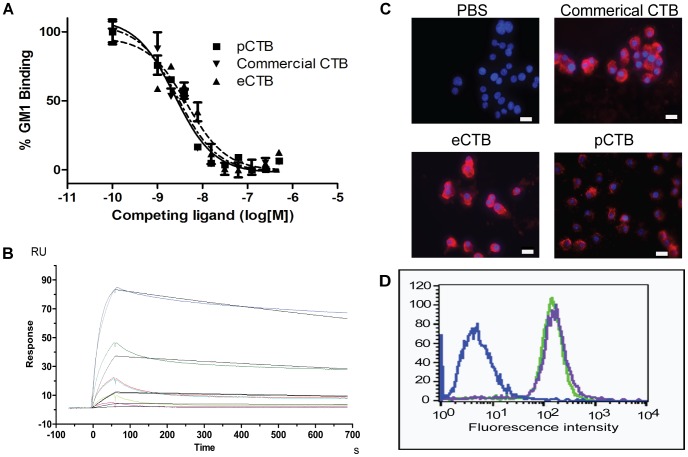
Characterization of pCTB's GM1-ganglioside-binding activity.
A, binding affinity determination based on competitive GM1-ELISA using HRP-labeled CTB. The assay was performed in triplicate. The 50% inhibitory concentrations (IC50) of commercial, p-, and eCTB were determined by non-linear regression analysis (GraphPad Prism 5.0) to be 2.44, 2.85, and 4.51 nM, respectively. B, SPR. Each CTB protein was immobilized on a sensor chip via a CTB-specific monoclonal antibody, and varying concentrations of GM1-ganglioside were used as analytes. For each protein the assay was performed in triplicate. A representative sensorgram obtained with pCTB is shown. The colored curves represent the concentration of GM1-ganglioside (10, 3.33, 1.11, 0.37, and 0.123 µg/ml from top to bottom), and the black lines are the 1∶1 binding kinetics fit. C, analysis of pCTB's binding to RAW264.7 by immunofluorescence. After 48 h incubation, binding of (a) a PBS control, (b) commercial CTB, (c) pCTB, and (d) eCTB to the cells was detected by anti-CTB primary and Cy3-conjugated secondary antibodies on a Zeiss Observer.Z1 microscope (40×magnification) with the Axiovision AxioVs40 V4.6.30 software. The red signals correspond to the presence of CTB proteins. Nuclei were counterstained with DAPI. No significant difference was noted in cell-surface binding or cell morphology among the three proteins. Scale bar, 20 µm. D, a representative flow cytogram showing RAW264.7 cells bound by e- and pCTB, as detected by Cy3-conjugated secondary antibodies. PBS, eCTB, and pCTB histograms are blue, purple, and green, respectively, demonstrating the comparable binding of the bacterial and plant-made aglycosylated B subunits to the cells.